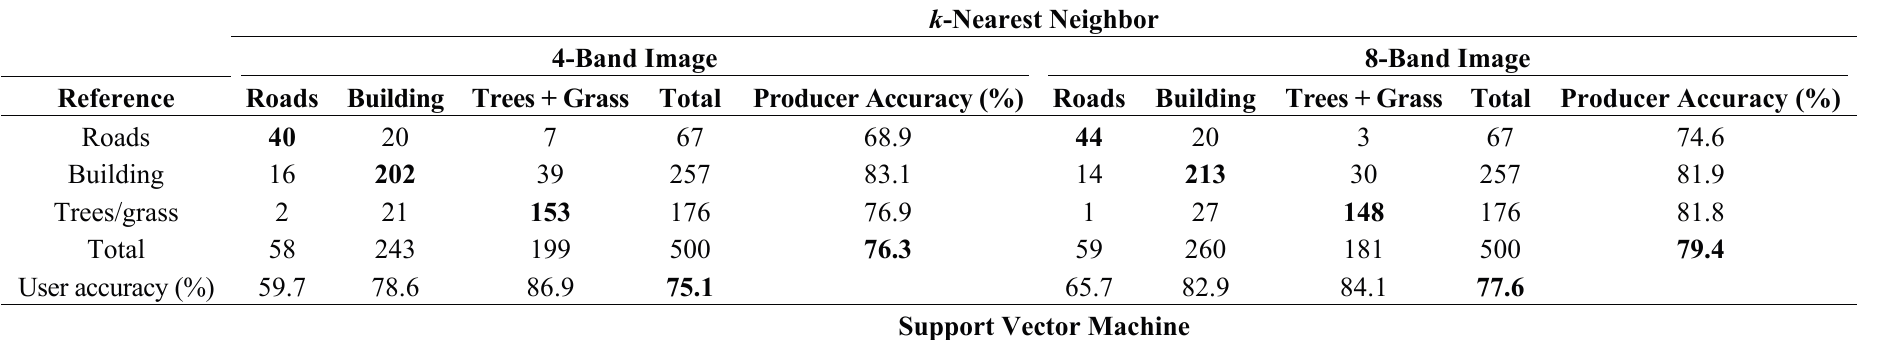
Table 4. Additional confusion matrix for k -NN and SVM classifiers; conducted with 22 attributes (4 spectral, 4 texture and 14 spatial